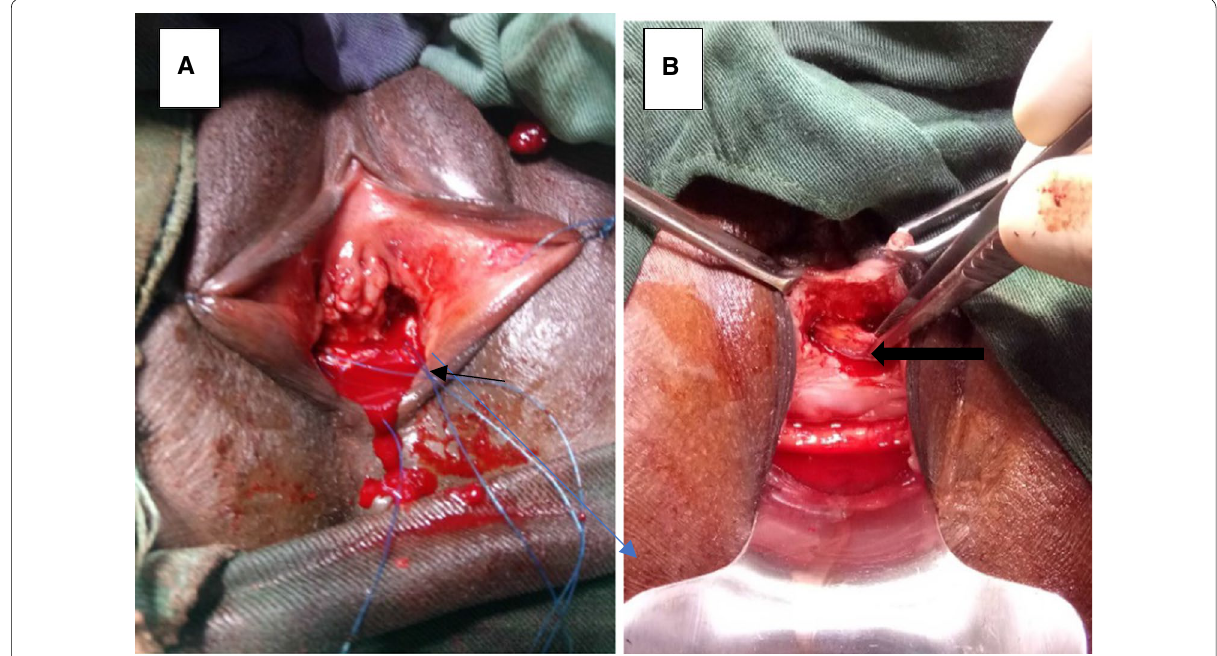
Fig. 3 a Stay suture attached to the end of the harvested rectus sheath (small arrow). b Vaginal assistant surgeon guides the fascial sling to come to lie over the mid‑urethral (large arrow)